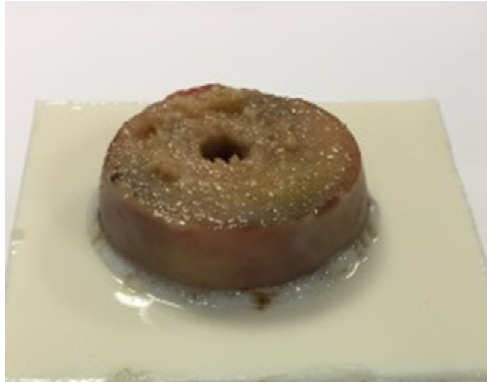
Figure 2. Embedded femoral head with drilled hole for the peg, prior to cleaning procedure.